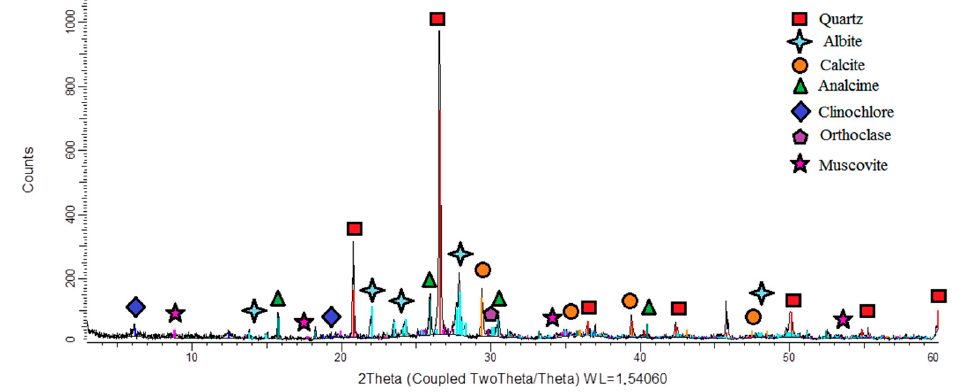
Figure 2. Phase composition of the original rock.